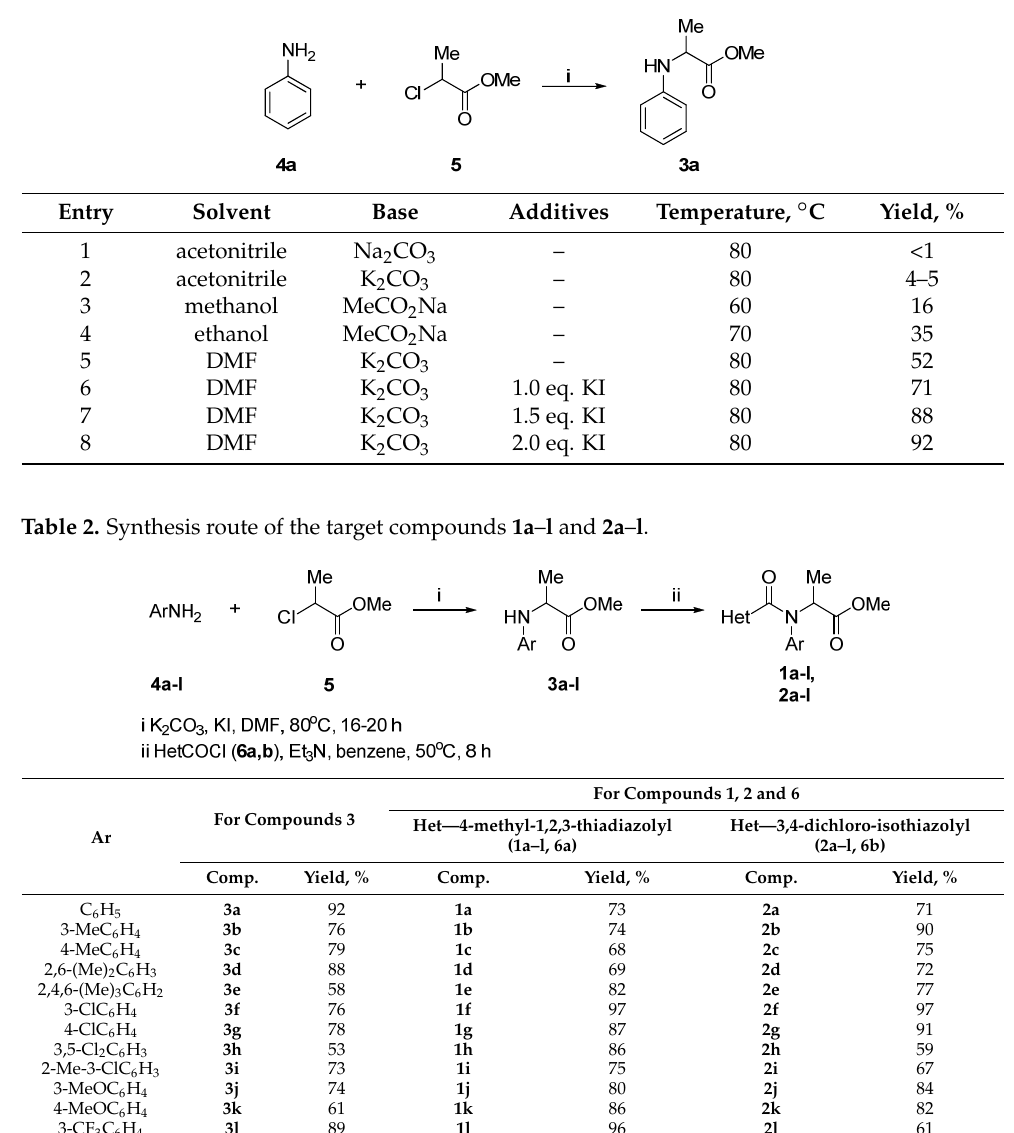
Table 1. Optimization of reaction for synthesis of compound 3a .